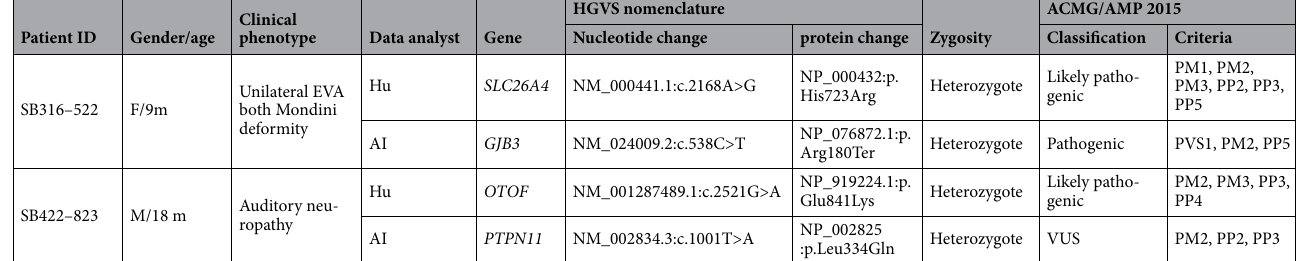
Table 3. The sensorineural hearing loss probands whose candidate variants were detected by humans. EVA enlarged vestibular aqueduct, Hu humans, AI